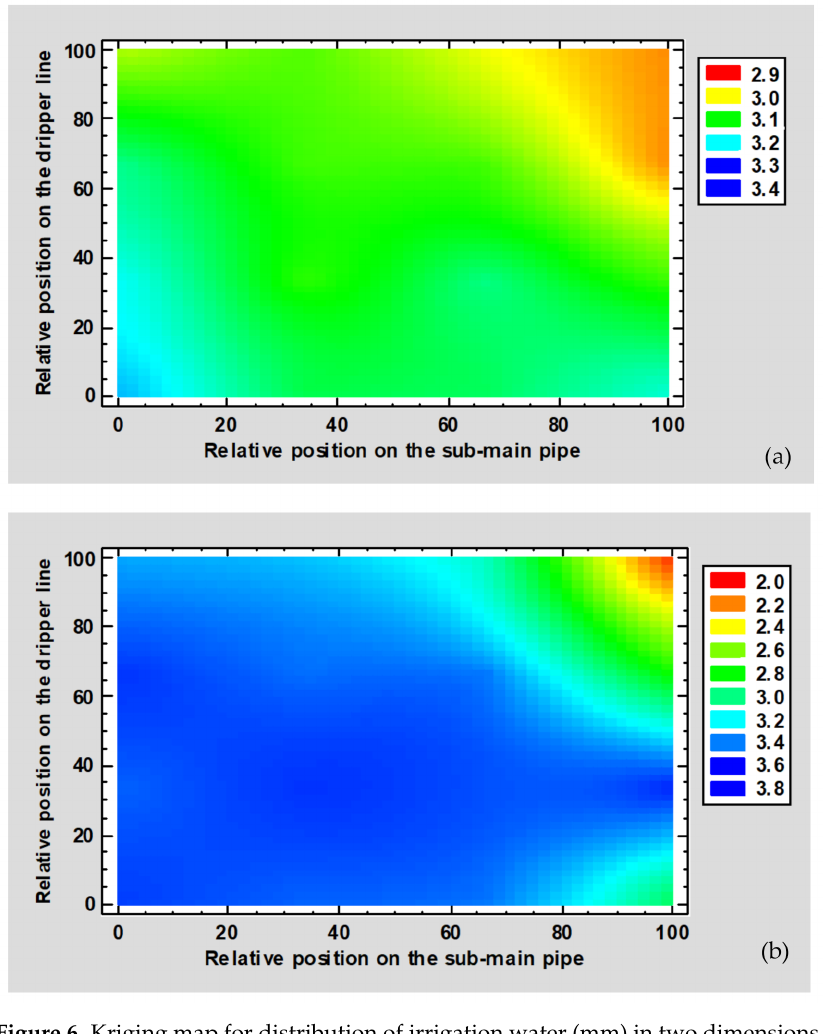
Figure 6. Kriging map for distribution of irrigation water (mm) in two dimensions in systems that use groundwater ( a ) and reclaimed ( b ) irrigation water of the greenhouses of Almer í a, where 0 corresponds to of the dripper line or sub-main pipe and 100 corresponds to the last emitter of the dripper line or sub-main pipe. Exponential adjustment with R 2 = 94.14%, root mean square error (RMSE) = 0.00102, and p ≤ 0.05 ( a ), and R 2 = 96.78%, root mean square error (RMSE) = 0.01742, and p ≤ 0.05 for ( b